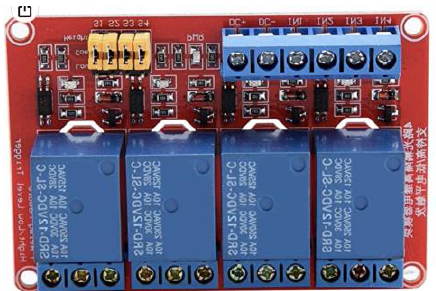
Figure 5. Victron MPPT Solar Controller.